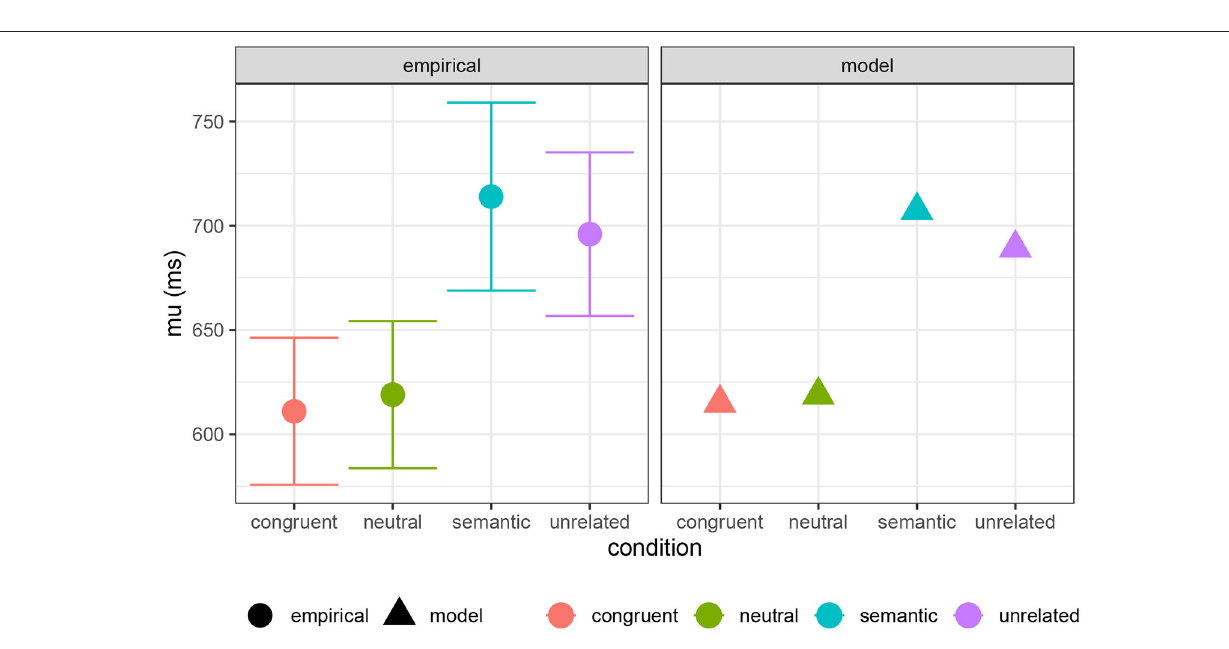
FIGURE 10 | Empirically estimated µ parameter of Ex-Gaussian RT distribution for PWI conditions from Roelofs and Piai (2017), compared with model predictions (see